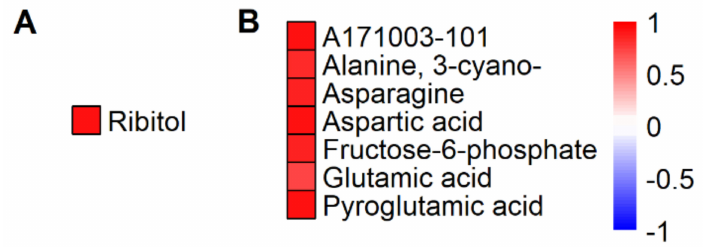
Figure 9. Metabolites with significant correlations (Spearman’s rank correlation, p < 0.05) between total grain yield reduction under HNT in the WS and the corresponding changes in metabolite contents (log 2 fold change) in flag leaves ( A ) and in panicles ( B ). Red color indicates positive correlations. Metabolites are sorted